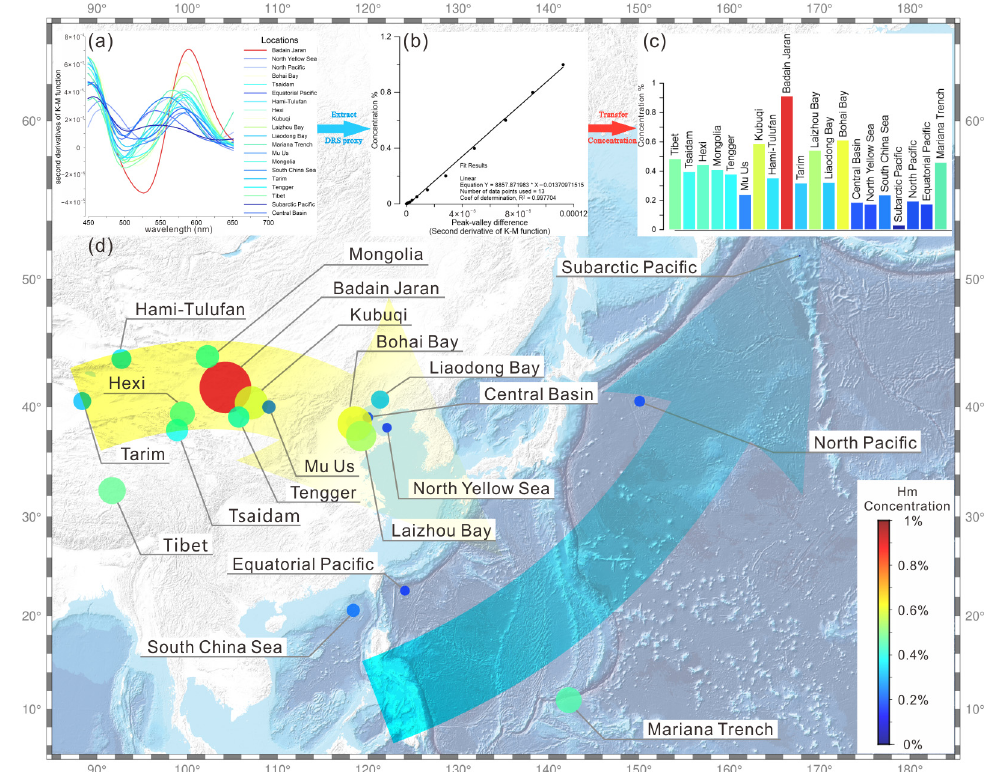
Figure 8. Estimated hematite concentration of natural samples (color and size of the circle both reflect the concentration of hematite). ( a ) The second derivative of the K–M function processing natural DRS curves. ( b ) Correlation between concentration and DRS proxy (referring to Section 3.2). ( c ) Statistical results of estimated hematite concentration for natural samples. ( d ) Location and estimated hematite concentration for natural samples (variations of concentration are indicated by the color bar).